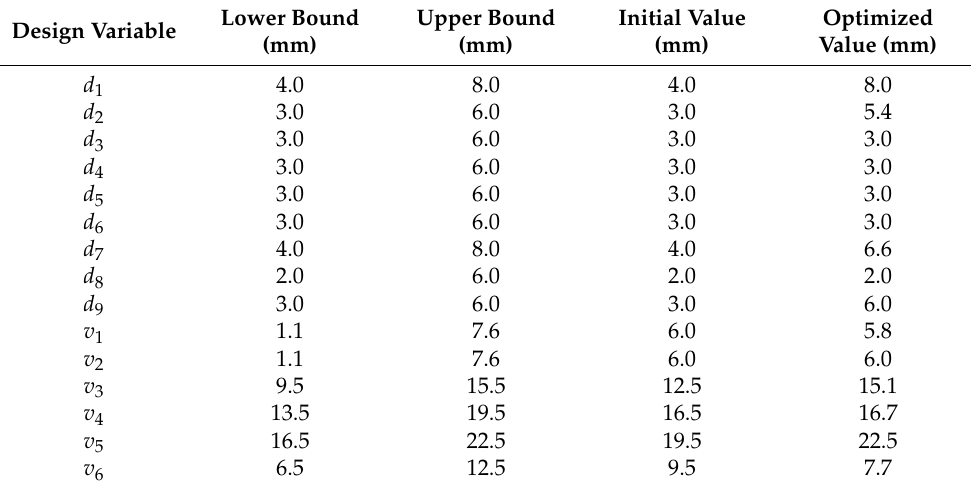
Table 3. Initial and optimized values of the design variables. Design